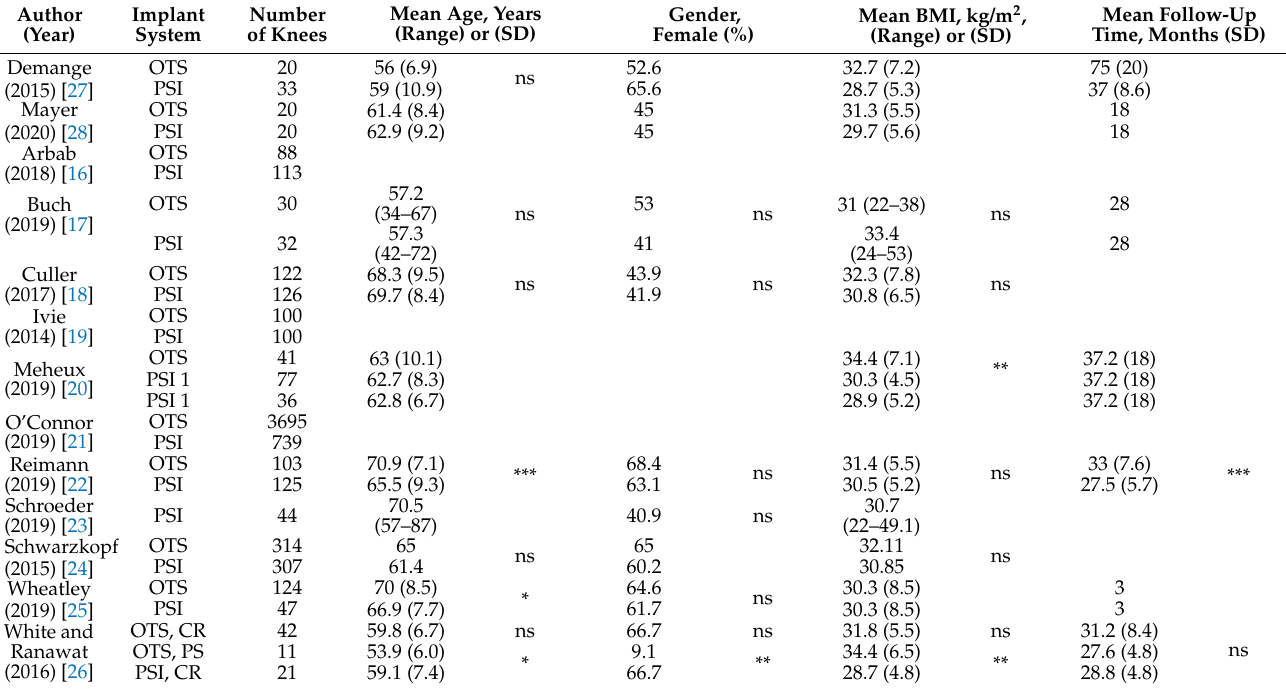
Table 2. Patient demographics at